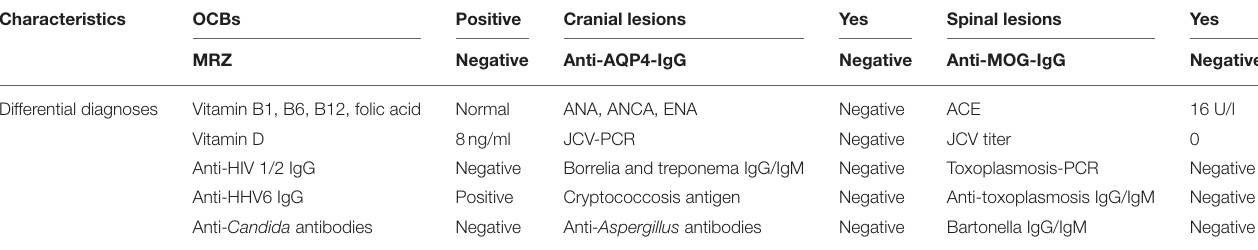
TABLE 1 | Laboratory characteristics and differential diagnoses.